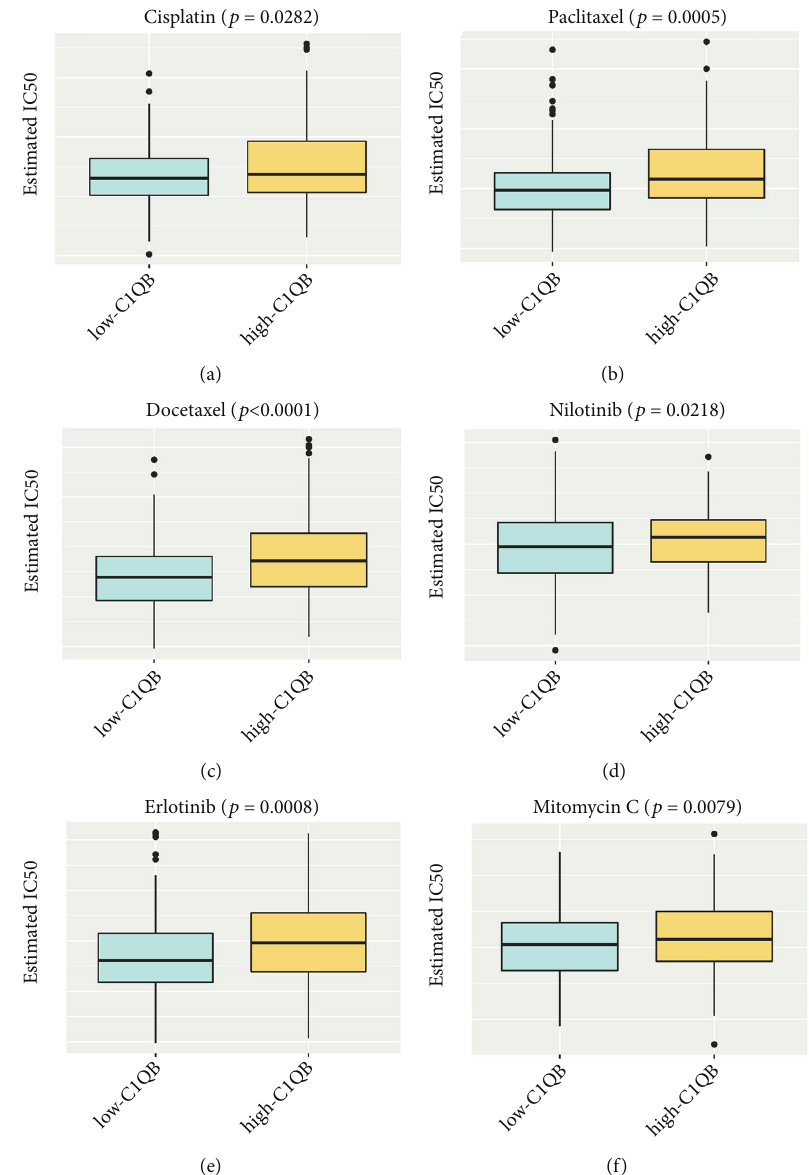
Figure 8: Estimated IC50 of cisplatin, paclitaxel, docetaxel, nilotinib, erlotinib, and mitomycin C between high C1QB expression and low C1QB expression groups with cervical